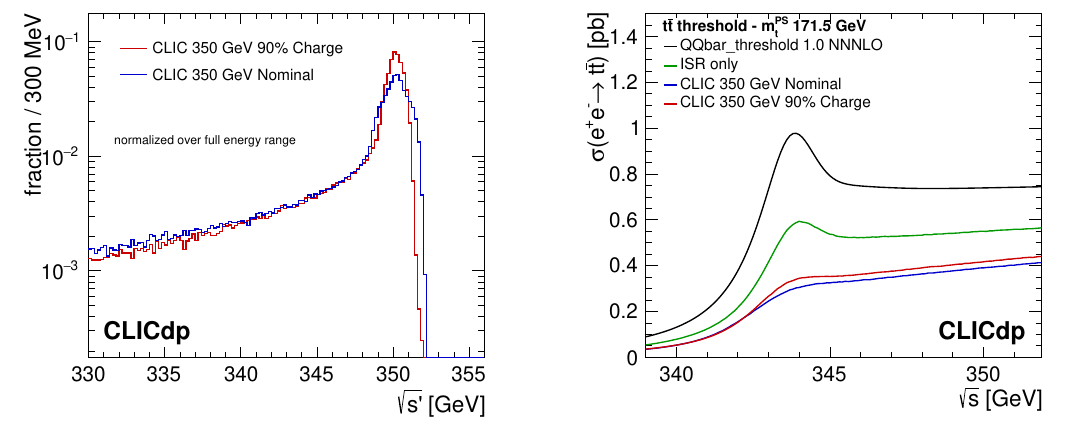
Figure 11. Two scenarios of the CLIC luminosity spectrum for a threshold scan (left); one based on the nominal accelerator parameters of the 380 GeV initial stage of CLIC (optimised for instantaneous luminosity), and one optimised for reduced beamstrahlung (‘reduced charge’). The impact of the luminosity spectra on the top-quark pair production cross section (right), where the blue and red curves show the observable cross section for the nominal and the ‘reduced charge’ luminosity spectra,